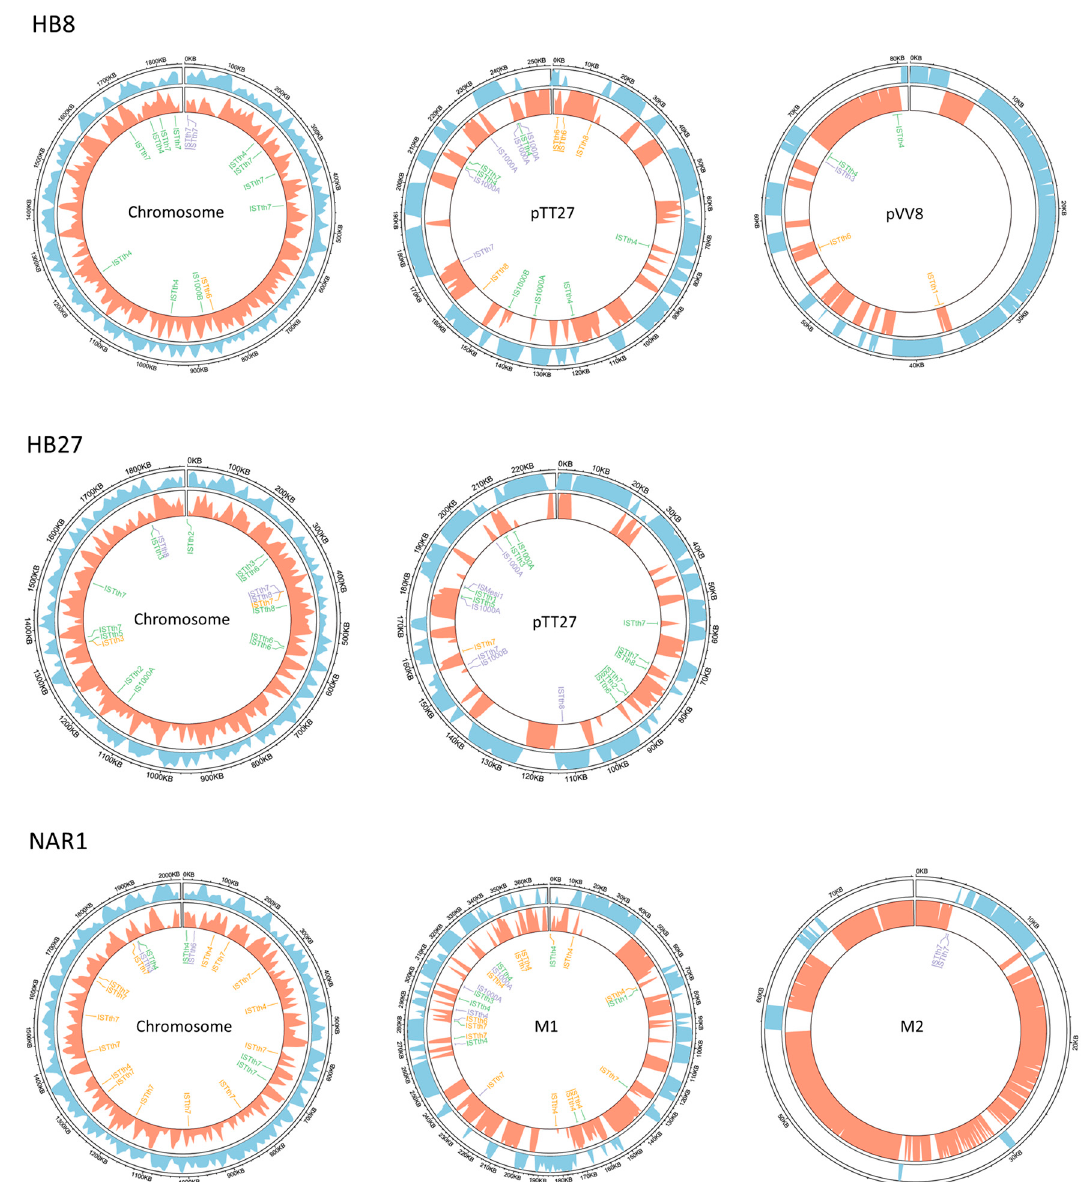
Figure 3. Location of ISs in the genomes of selected strains. The chromosome and megaplasmids (pTT, pTT27, PVV8, M1, and M2) of the T. thermophilus strains HB8, HB27, and NAR1 are represented as circles, with blue and orange shading indicating the coding densities of both DNA strands. Positions of the indicated IS are labeled with color codes indicating putatively active (green), inactive but complete (orange), or incomplete (purple). The replicons are drawn at different scales.